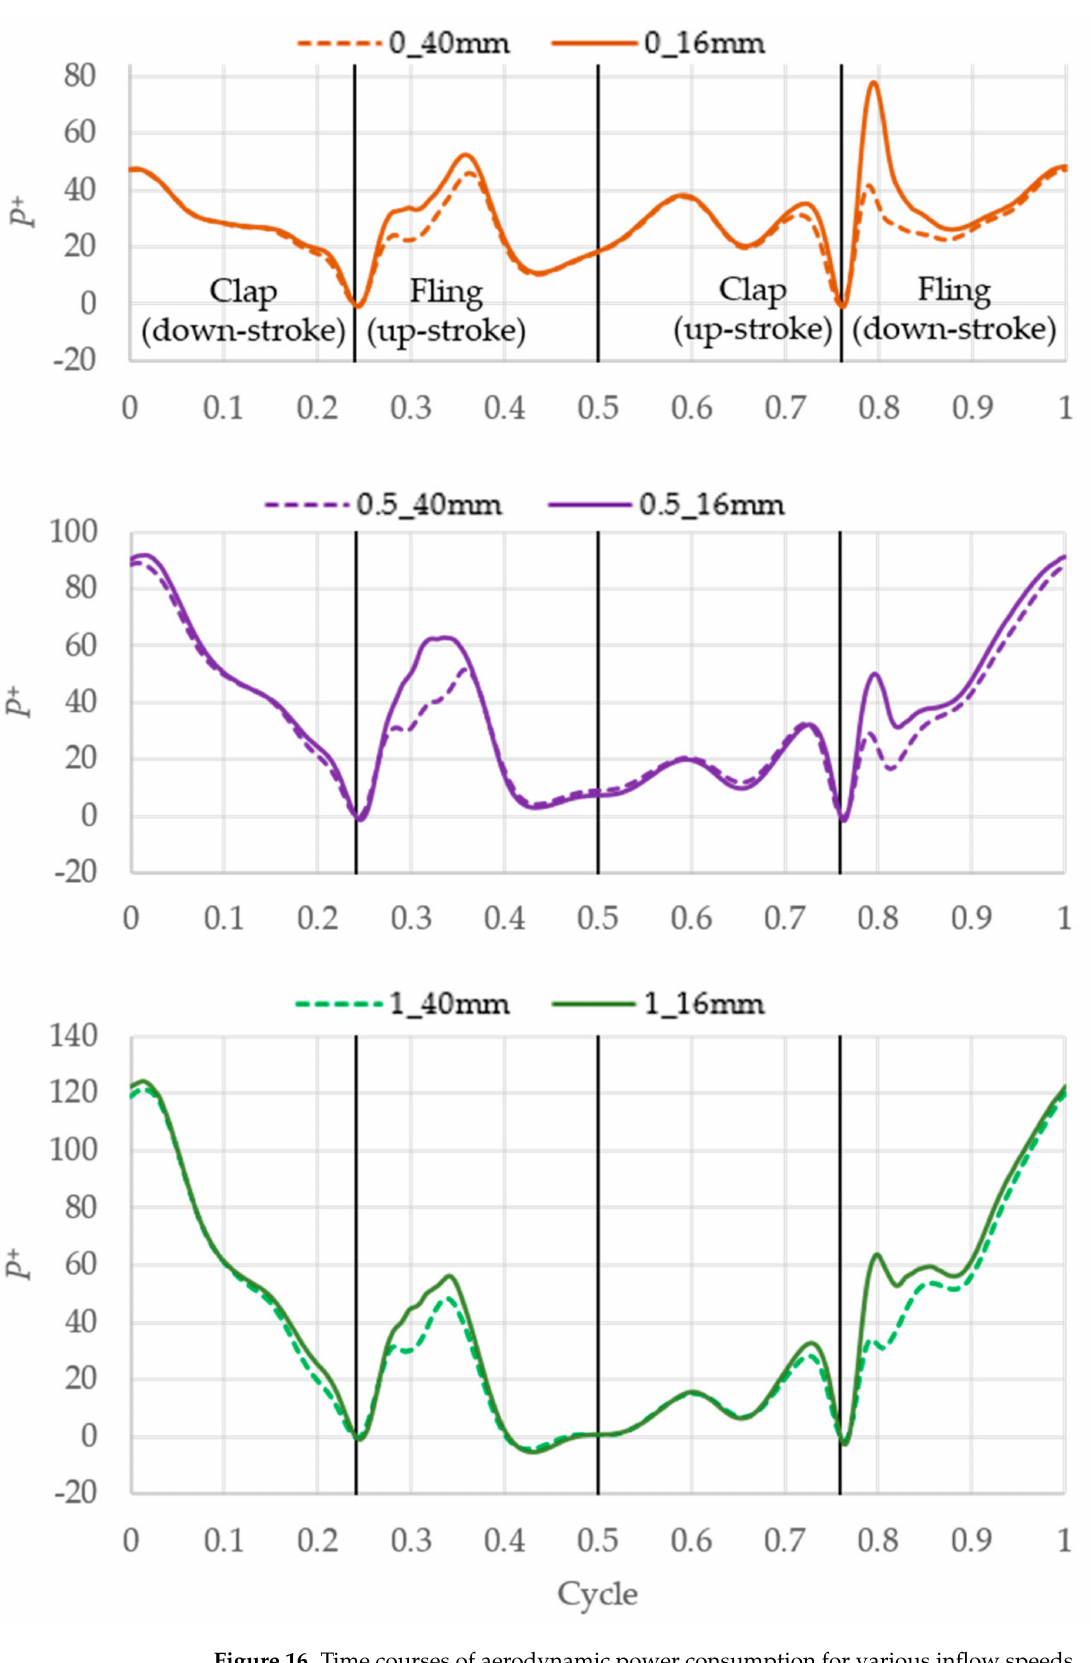
Figure 16. Time courses of aerodynamic power consumption for various inflow